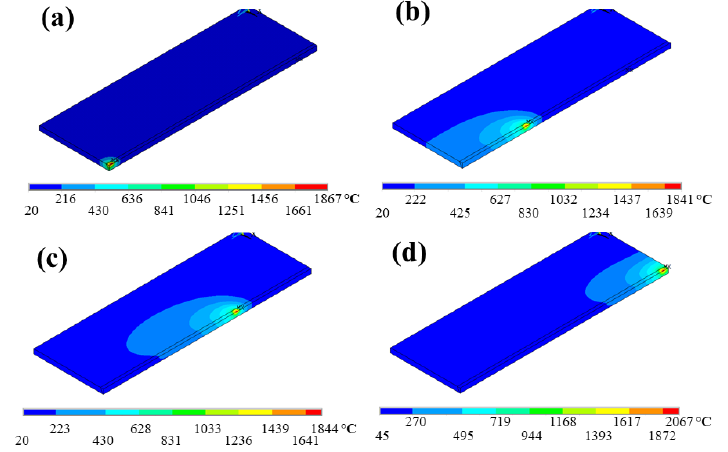
Figure 10. Finite element temperature distribution generated by the heat welding source, ( a ) 2.75 s, ( b ) 25.0 s, ( c ) 50.0 s, and ( d ) 75.0 s.